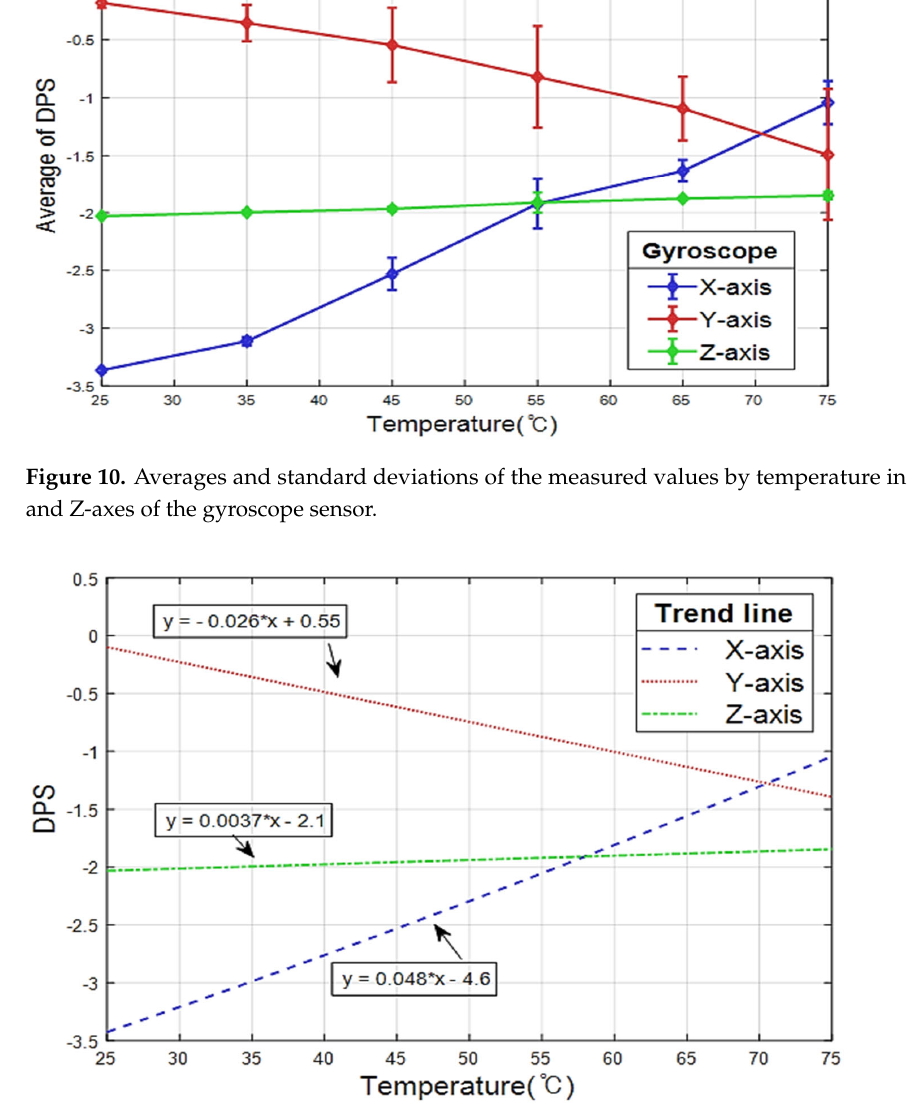
Figure 12. Noise distribution chart of the X ‐ axis of the gyroscope sensor. Figures 13a–c show the deviation analysis of the measured values at temperatures 25 °C, 55 °C, and 75 °C in the Y ‐ axis of the gyroscope sensor. The Y ‐ axis of the gyroscope sensor showed an evident change in deviations as the temperature increased. In particu ‐ lar, the largest deviation value was revealed at 75 °C among all experimental deviation values.